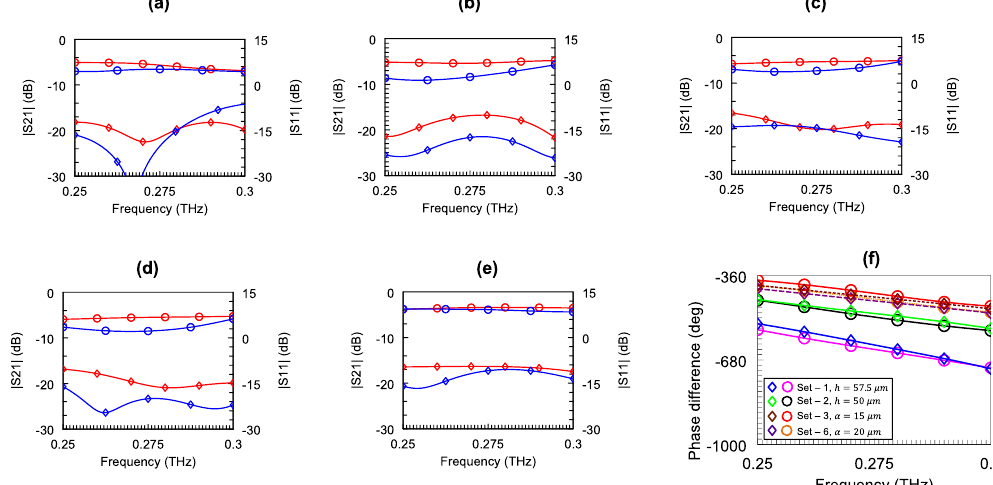
Figure 3. The comparison of the measured and simulated S-parameters (measurements (S 11 , S 21 ( , )) and simulations (( , ))): Set 1, h = 57.5 μ m ( a ), Set 2, h = 50 μ m ( b ), Set 3, a = 15 μ m ( c ), Set 6, a = 20 μ m ( d ), and reference line ( e ). Relative insertion phases of the delay lines with respect to the reference line: Set 1, h = 57.5 μ m, Set 2, h = 50 μ m, Set 3, a = 15 μ m and Set 6, a = 20 μ m, measurements ( , ○ , , ) and simulations ( , , , ), respectively ( f ).